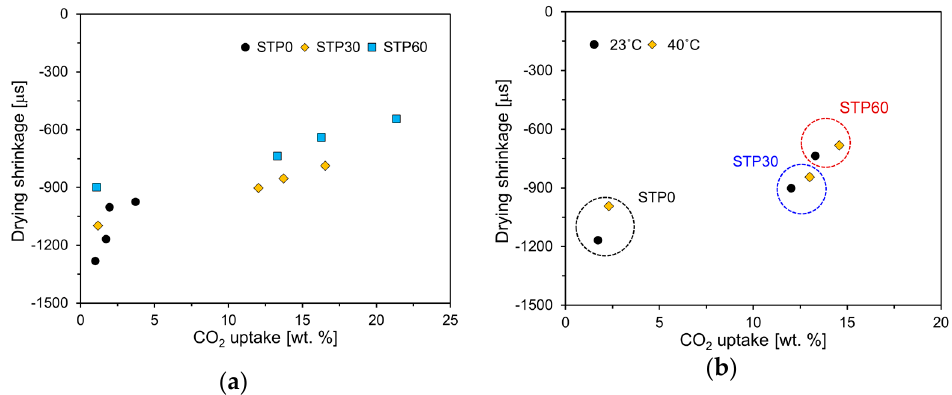
Figure 14. Comparison between CO 2 uptake and drying shrinkage: ( a ) CO 2 concentration and ( b ) curing